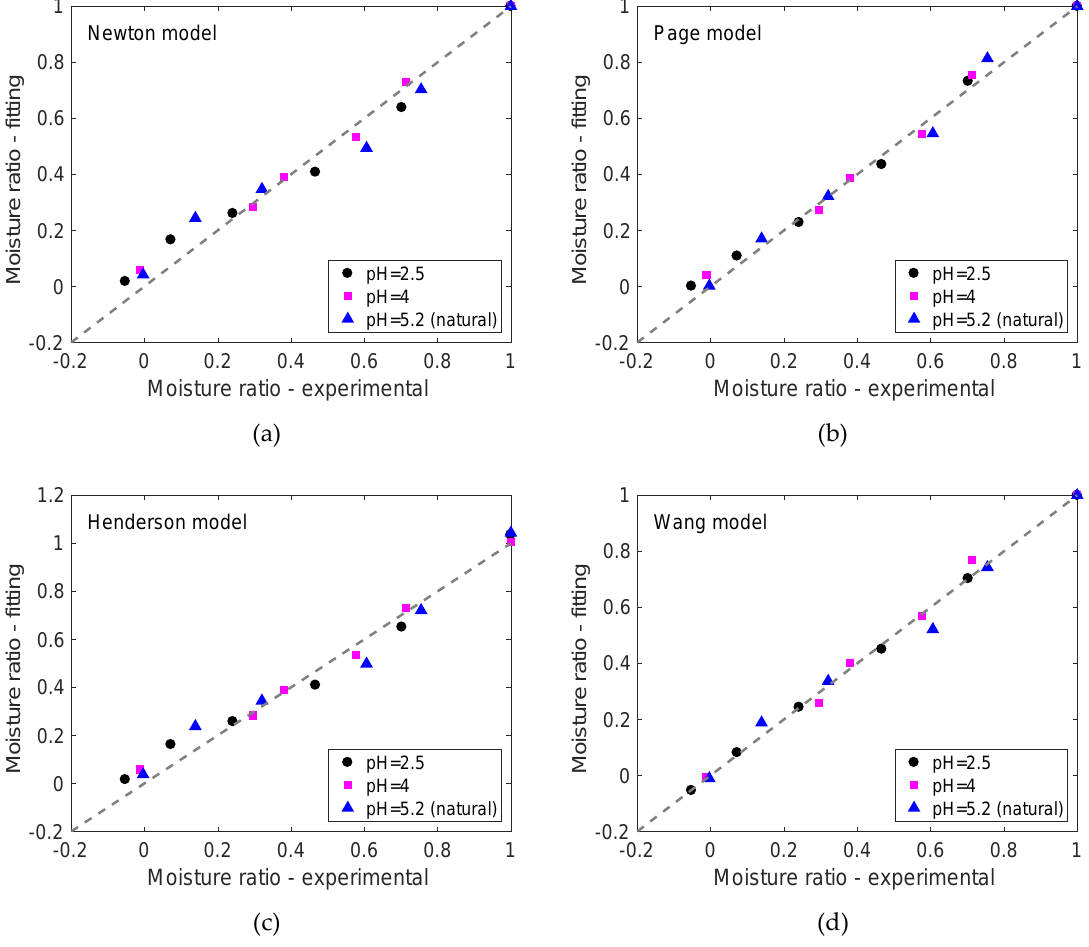
Figure 2. Correlation between predicted and experimental moisture contents for freeze-dried 2% (w/w) gellan gum samples for: ( a ) Newton model (Equation 2), ( b ) Page model (Equation 3), ( c ) Henderson and Pabis model (Equation 4) and ( d ) Wang model (Equation 6).